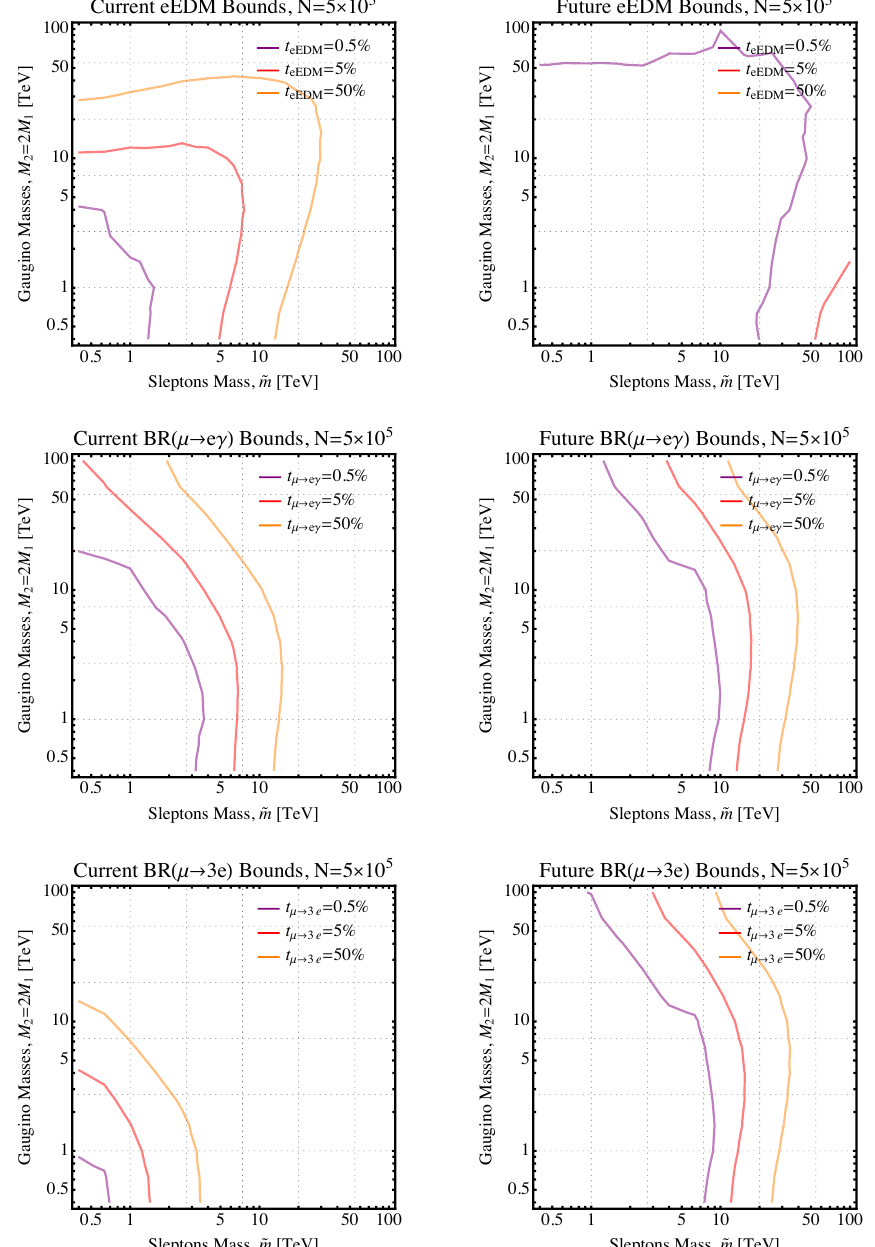
Figure 4 . Similar to figure 3 but for the charge assignment [ S 2 ] = − 4 and { [ L 1 ] , [ L 2 ] , [ L 3 ] , [¯ e ] , [¯ e ] , [¯ e ] } = { 4 , 2 , 2 , 2 , 1 , − 1 } (the second row of table 1 2 3